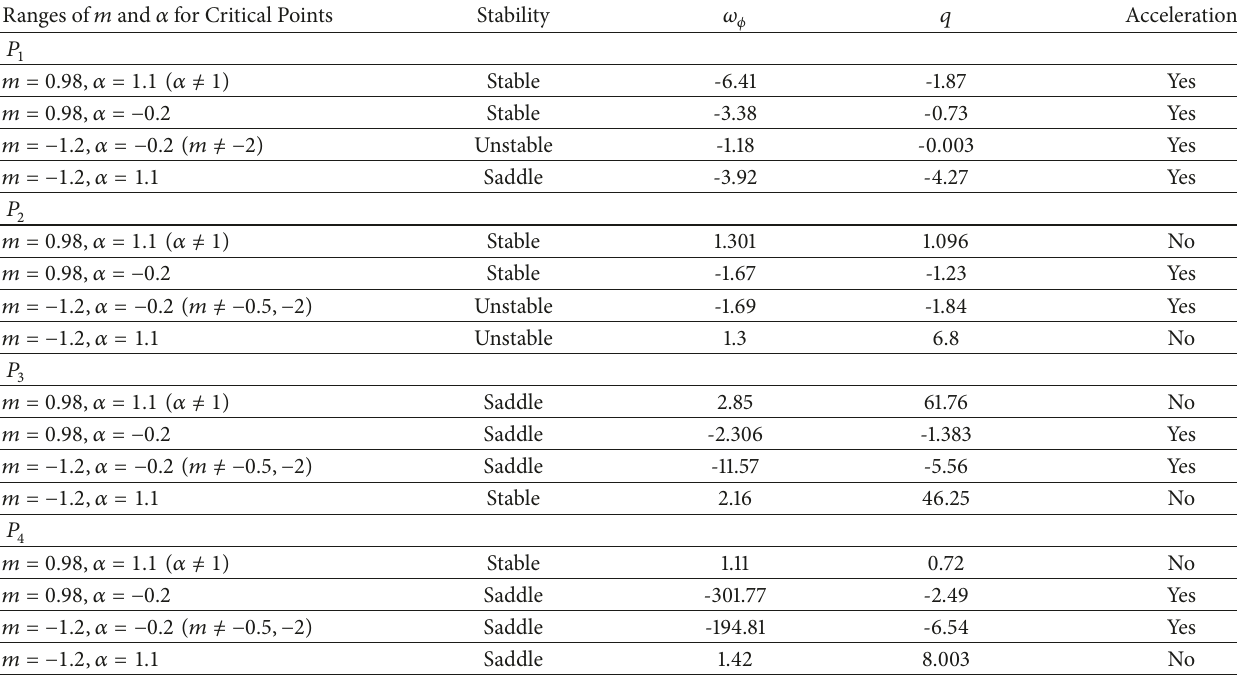
Table 1: Phase Space Analysis for the Phantom Coupled System with 𝑄 = 𝛼 ̇𝜎 𝑚 . Ranges of 𝑚 and 𝛼 for Critical Points